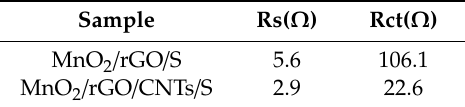
Table 1. The EIS data of the